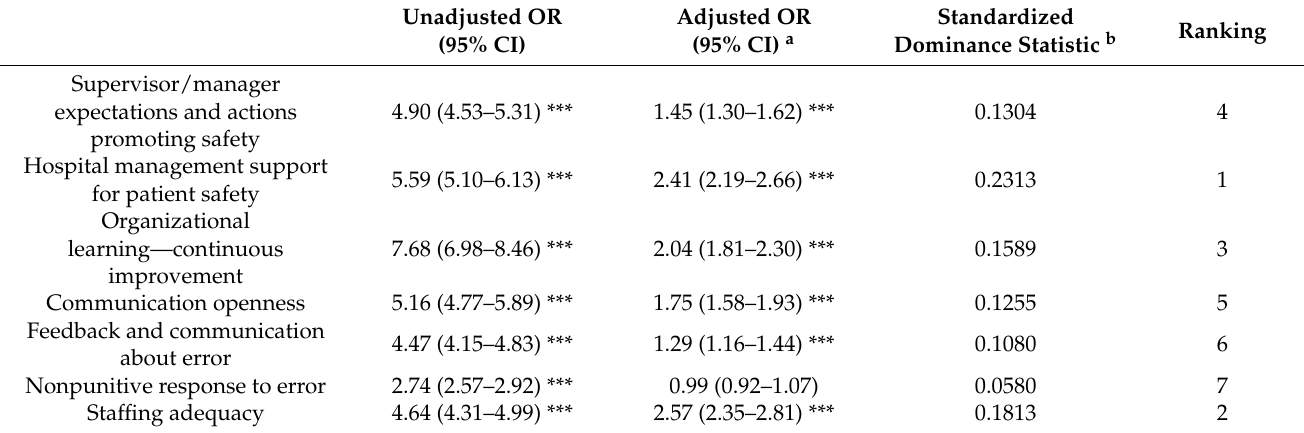
Table 3. Logistic regression and importance of predictors on nurse-rated patient